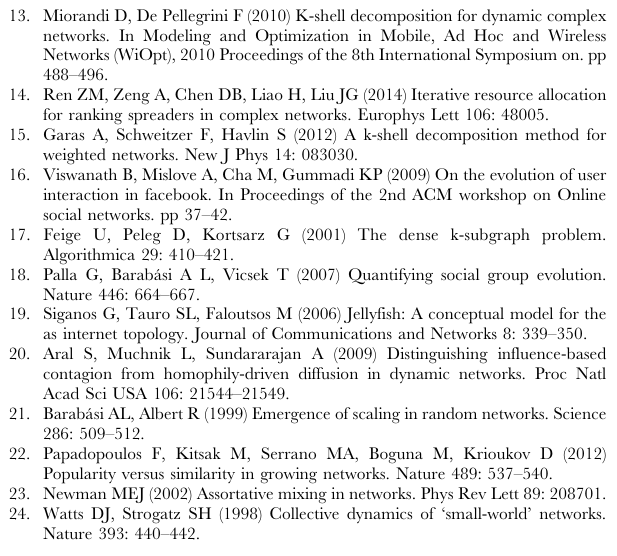
Figure 7. (Color online) Statistical properties of the network size N(t) (a) and the corresponding network core sizes n the relative growth rate p(t) (c). (a) The growing tendency of the size N ( t ) of the FL and FW networks obey an exponential form with exponent l 1 =0.076 6 0.002 (inset l 2 =0.030 6 0.002). (b) The core sizes n(t) are around 672 and 373. (c) The core relative growth rate ( ) fluctuates around 0.